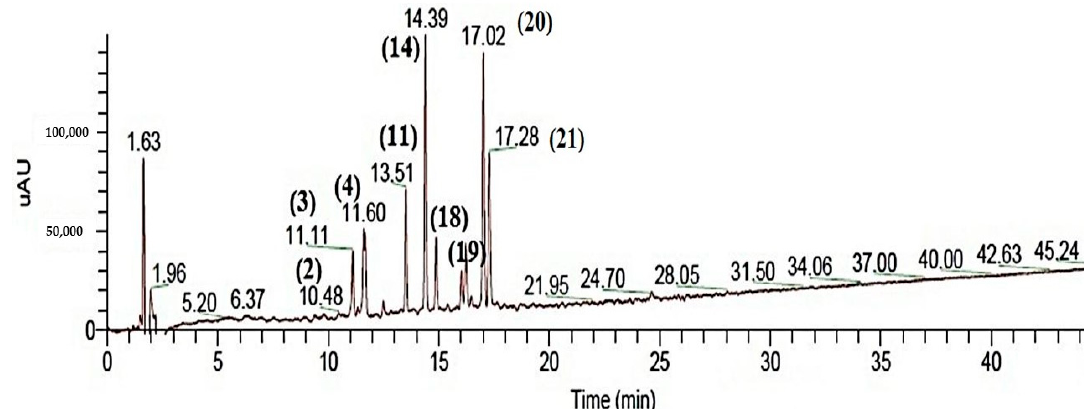
Figure 1. HPLC-PDA-ESI-MS / MS chromatogram for metabolites detected in a hydroalcoholic fruit extract of SJ (negative mode).